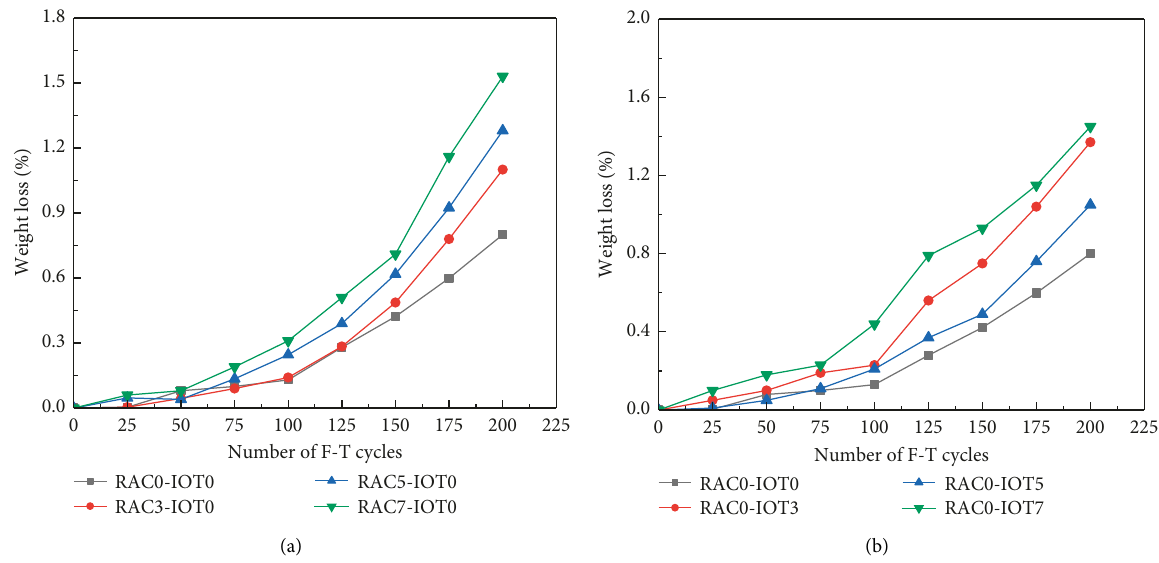
Figure 7: Mass loss rate of iron ore tailings recycled aggregate concrete during F-Tcycle: (a) the dosage of IOTis 0%; (b) the dosage of RCA is